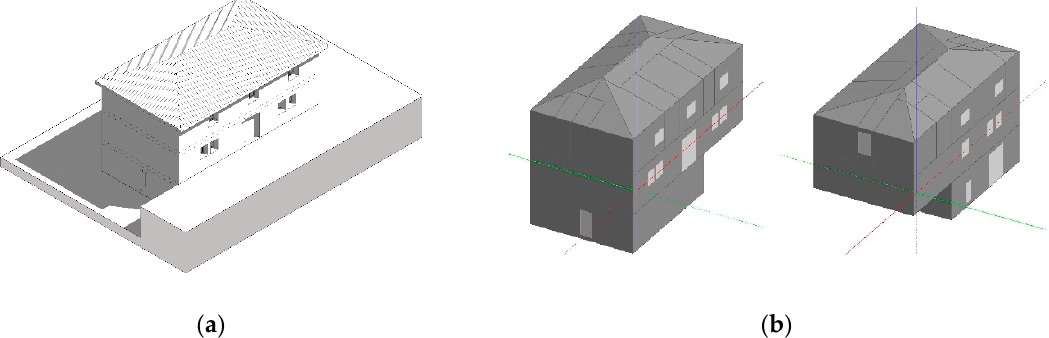
Figure 3. Building model: ( a ) simplified Revit model to be imported in DesignBuilder; ( b ) simulation model, front and back view. Table 1. Thermo-physical properties of transparent materials.